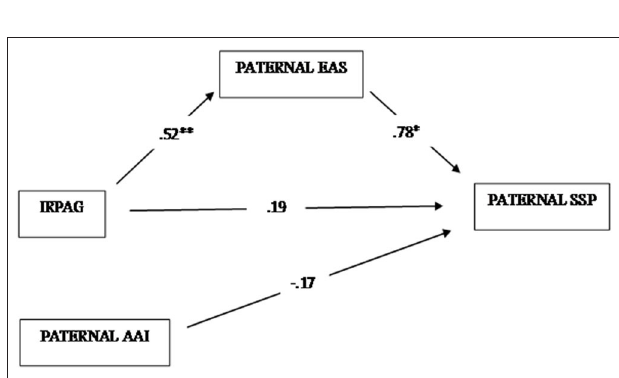
FIGURE 2 | Mediation model on children’s attachment toward fathers. *significant effect at 0.05 alpha level (two tails); ** significant effect at 0.01 alpha level (two